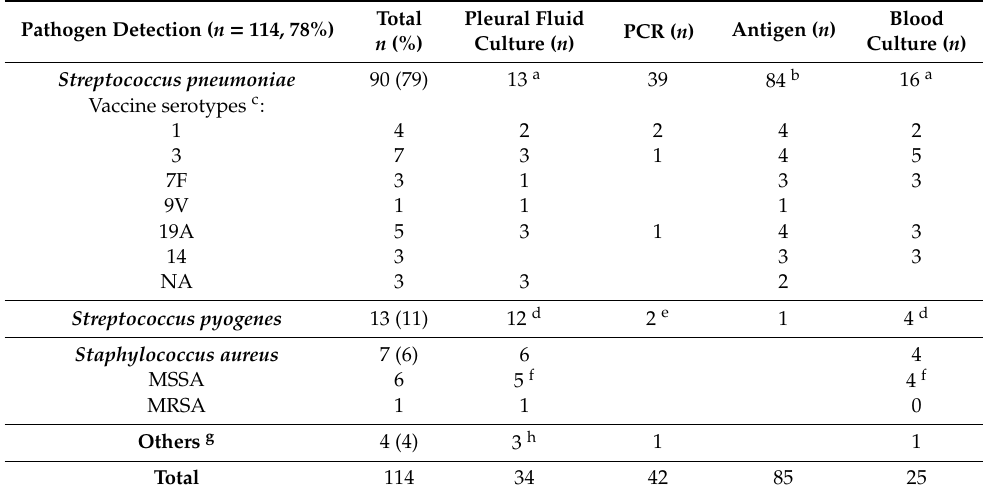
Table 2. Microbiological diagnosis in 114 out of the 147 children with PPE / PE. Total Pleural Fluid Pathogen Detection ( n = 114, 78%) Streptococcus